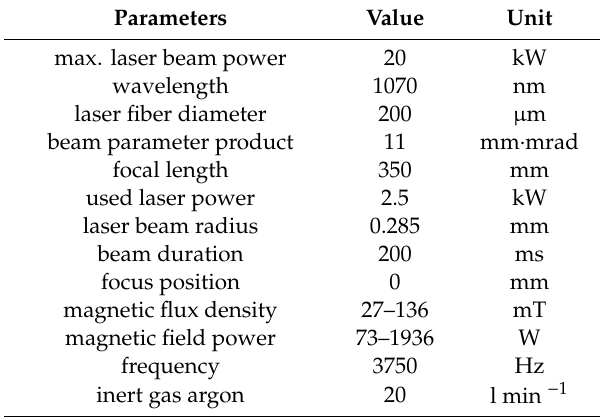
Table 4. The used experimental process parameters and optical components.